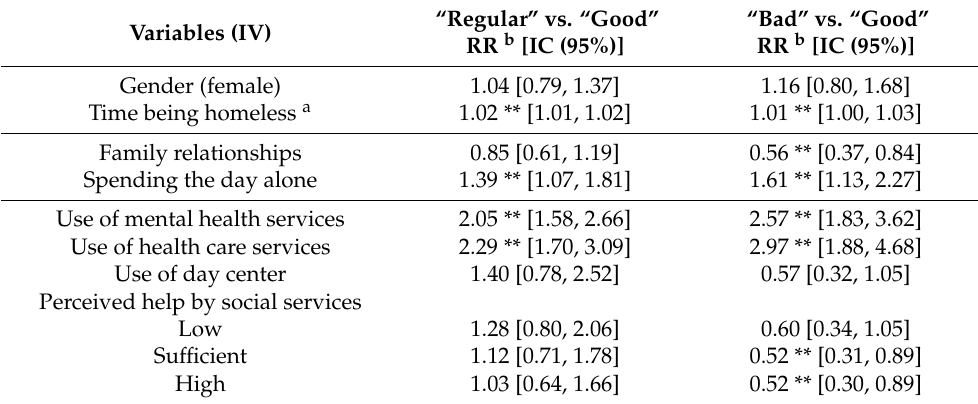
Table 2. Unadjusted estimates (relative risk ratios) of the impact of some variables on the self- perceived health